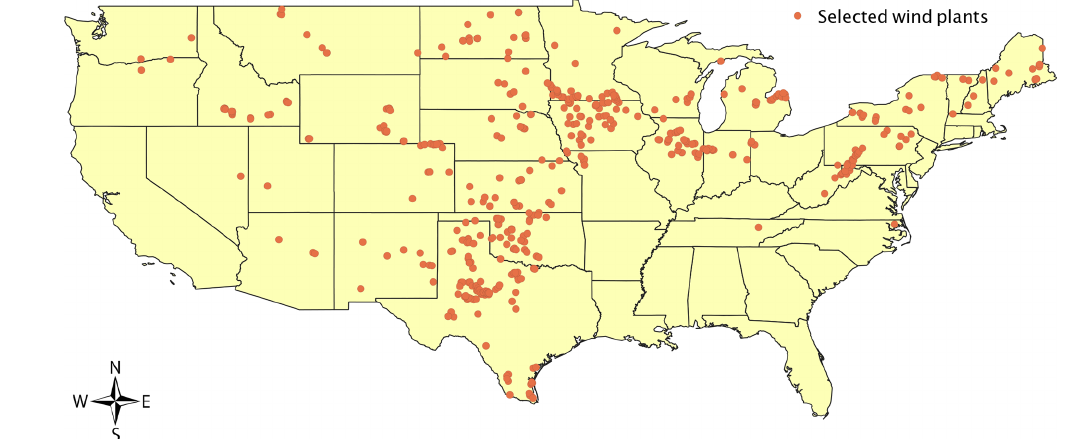
Figure 1. Map of the 472 wind plants that were considered in this study.